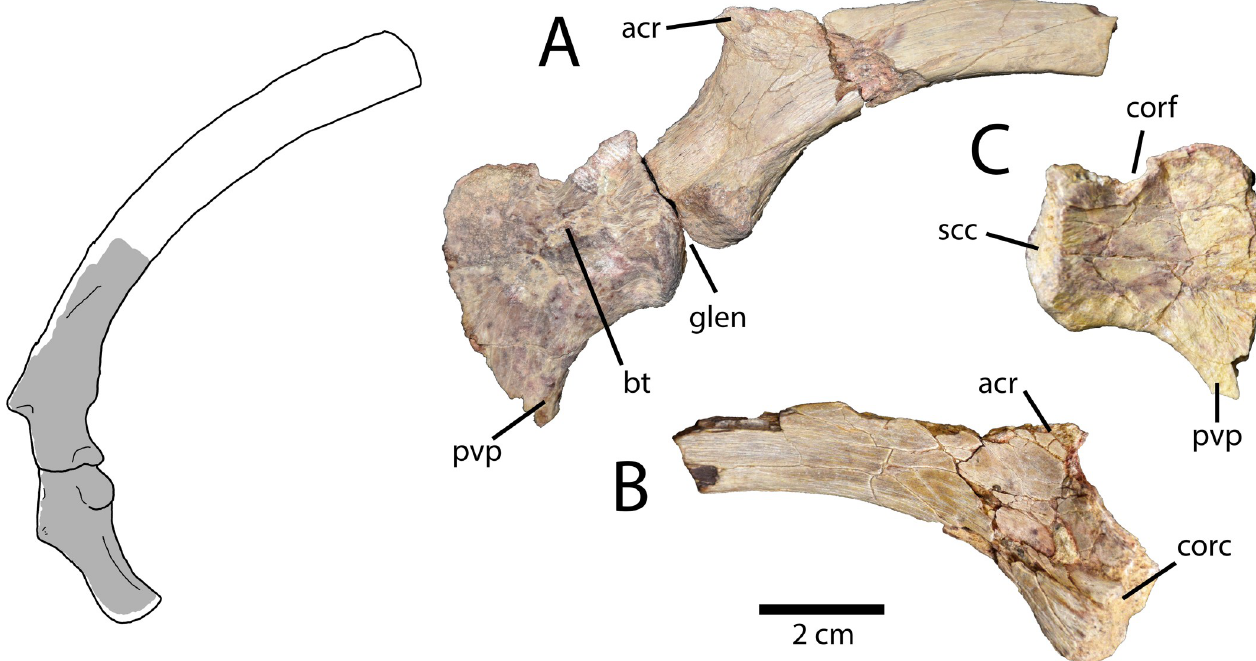
Fig 3. Pectoral girdle of Elmisaurus rarus (MPC-D 102/113). A , Left scapulocoracoid in lateral view. B, Left scapula in medial view. C , Left coracoid in medial view. Interpretive illustration of Apatoraptor pennatus (TMP 1993.051.0001) shows the approximate locations of the preserved portions. Abbreviations: acr , acromion process; bt , biceps tubercle; corc , coracoid contact; corf , coracoid foramen; glen , glenoid; pvp , posteroventral process; scc , scapular contact.